Question: Provide a one-line summary of what is displayed.
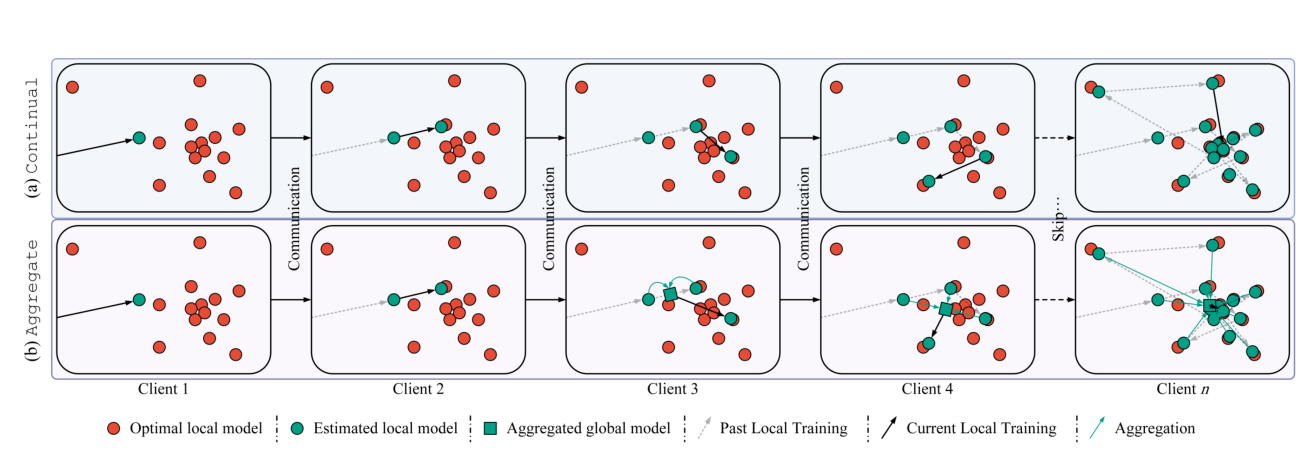
Answer: Illustration of the two paradigms, Continual and Aggregate, for sequential pointing line DFL in the parameter space, showcasing their respective learning and communication processes. The length of the arrow represents both the learning difficulty and the magnitude of the model parameters that undergo changes during learning, which can be measured using the ℓ2 norm. Shorter arrows are desired as they indicate more accessible, stable, and accurate model learning and convergence. Excessively long arrows suggest that the given loss function and learning rate may not produce the desired model outcome.